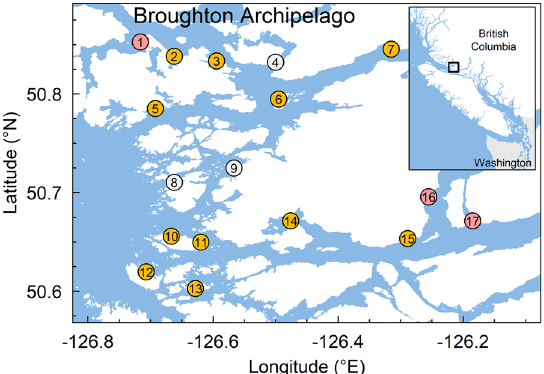
Figure 1. Map of salmon farms active between 2010 and 2021 in the traditional territories of the Mamalilikulla, ‘Na ̱ mg ̱ is, and Kwikwasut’inuxw Haxwa’mis First Nations in the region now known as the Broughton Archipelago, British Columbia, Canada. Orange points represent farms that performed at least one bioassay, pink points are farms that performed EMB treatments but no bioassays, and grey points are farms that performed neither EMB treatments nor bioassays (between 2010 and 2021). Numbers correspond to the Farm IDs in Table S1. The spatial extent of the main panel is indicated by the black rectangle in the inset.